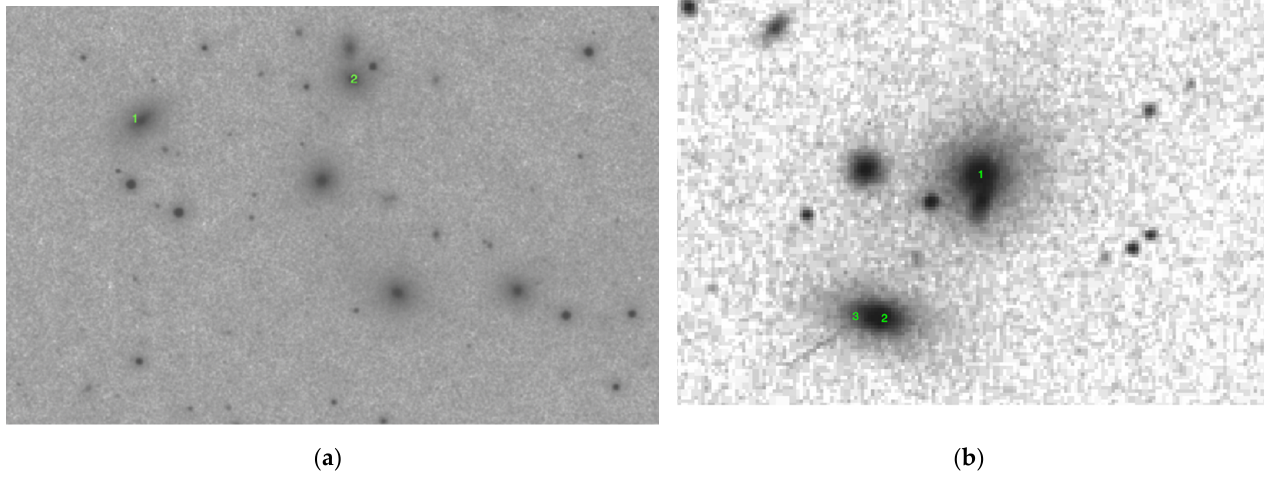
Figure 2. ( a) XMM X-ray sources coincident with the galaxies on the DSS image of HCG 15. ( b ) Chandra X-ray point sources on selected galaxies in HCG 51 (missing group galaxies do not have point sources).